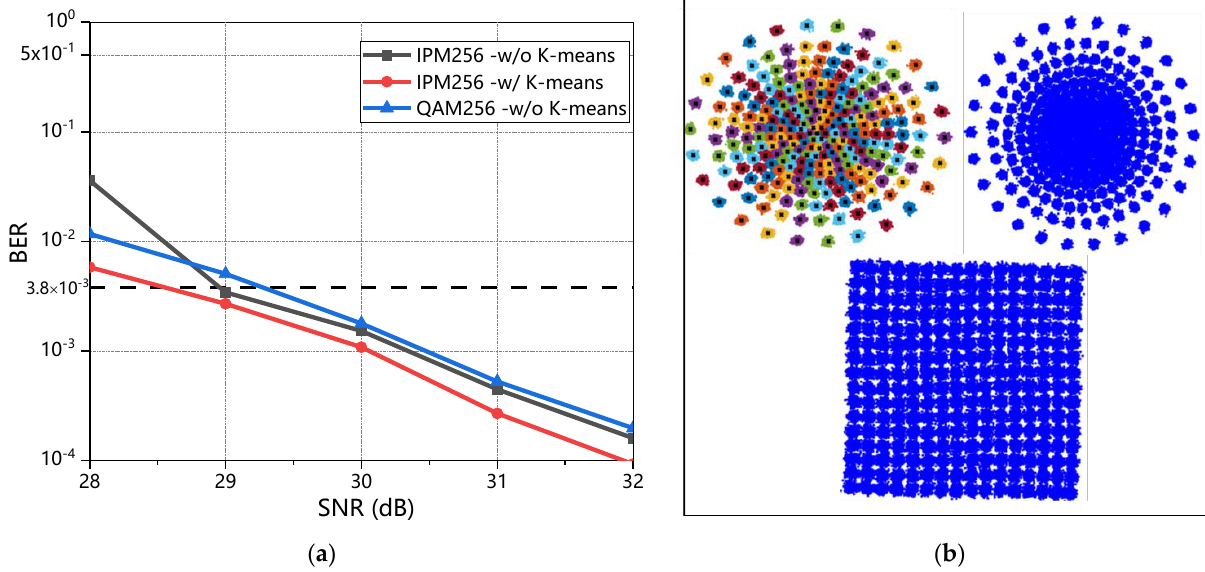
Figure 7. ( a ) BER versus SNR at loop = 1; ( b ) recovery constellation at SNR = 28 dB; black intersections: ideal constellation points under impacting by NLPN (associated centroids); colored dots: the signals in the cluster associated with the nearest black intersections.